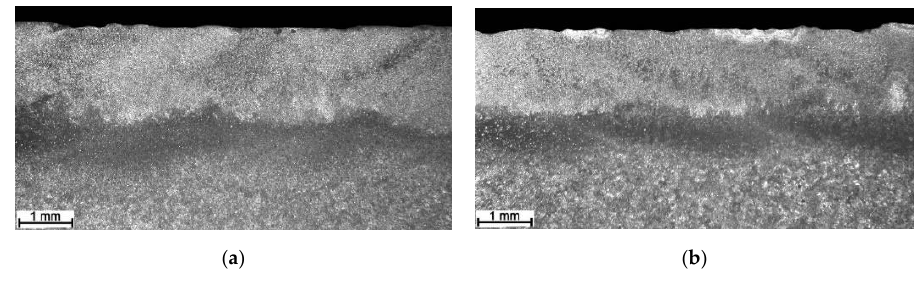
Figure 4. Optical macrographs of ( a ) TRC and ( b ) TRM (Table 3).